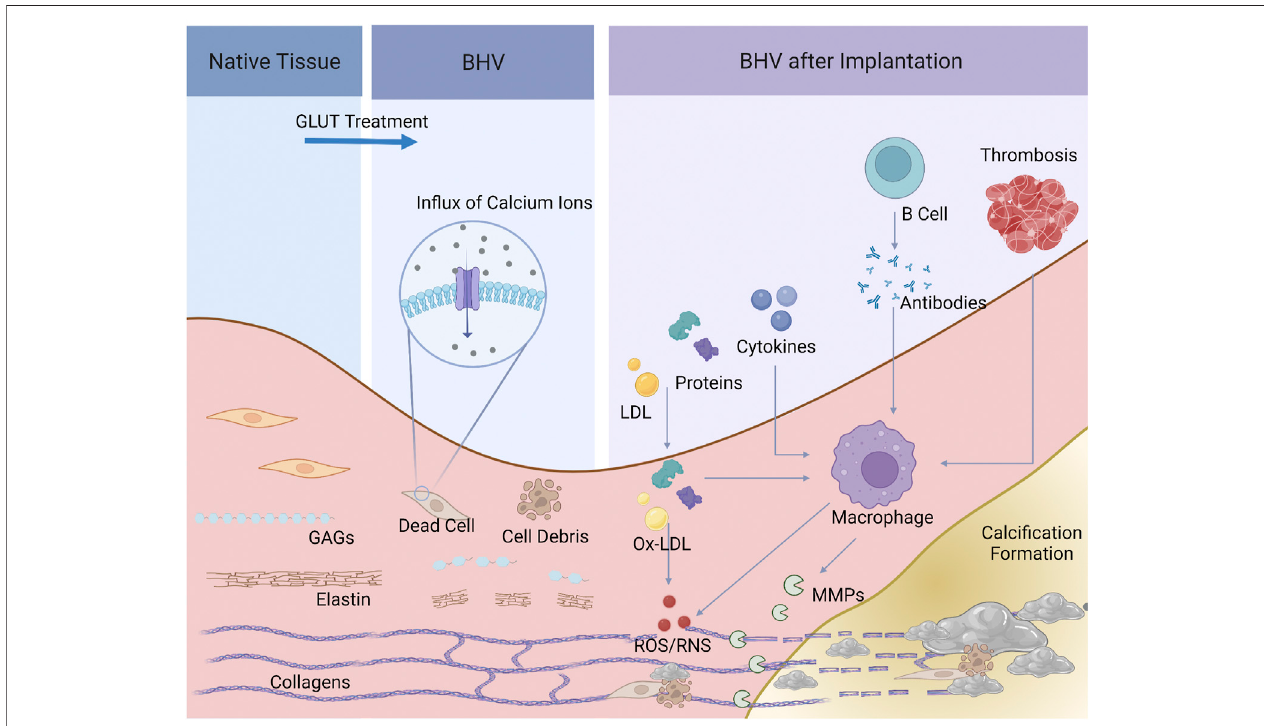
FIGURE2| SchematicoftheprocessofBHVcalci fi cation.Deadcellsandcelldebris,andelastinandGAGsdegradation,andcollagencrosslinkswerepresentafter GLUTtreatment,providingcalciumionsandthespeci fi cspacestructureforcalci fi cation.Serumproteinandlipidin fi ltrated,cytokines,xenoantibodiessecretedbyBcells and thrombosis would activate macrophages and induce in fl ammatory response. Macrophages further secret MMPs and product ROS/RNS, leading to BHV calci fi